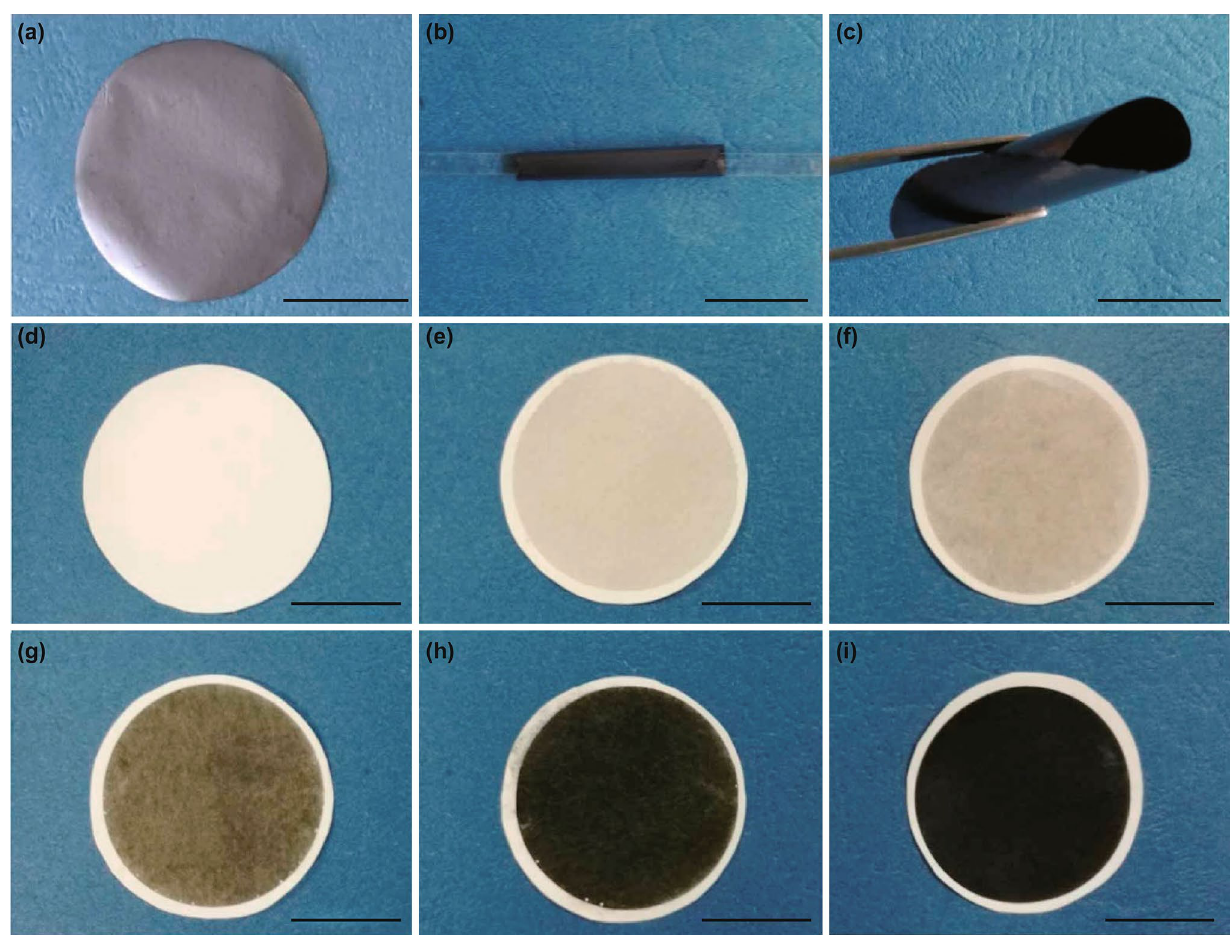
Fig. 16 Digital images of membranes a freestanding MXene membrane, b, c folded MXene membrane, d–i MXene membrane with different deposition amount, i.e., (0, 3.662, 7.325, 18.31, 36.62, 73.25) × 10 −6 g cm −2 . Reprinted with the permission from Ref. [75]. Copyright © (2017) Elsevier